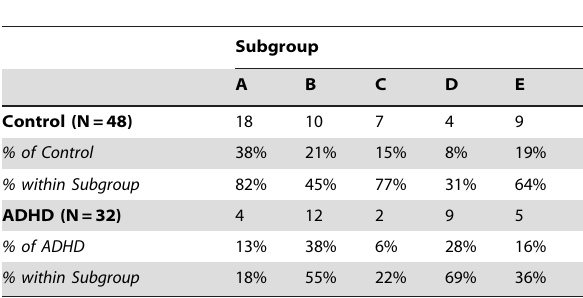
Table 3. Group affiliation by ADHD diagnostic